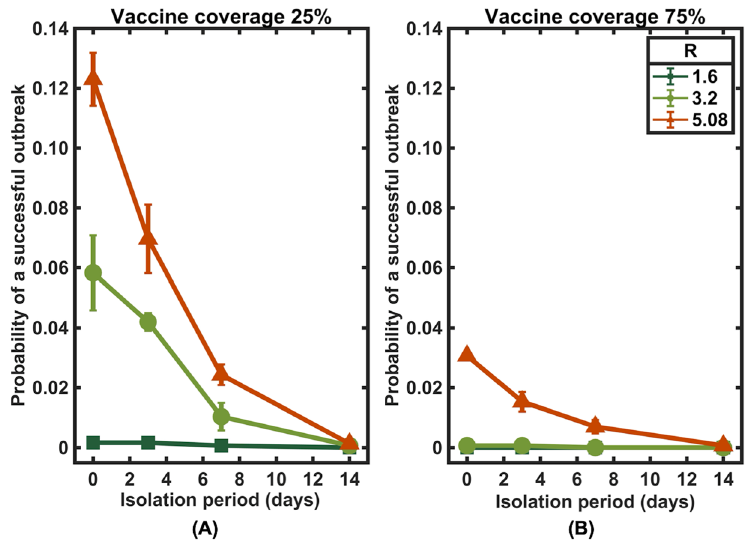
Figure 7. A sensitivity analysis of the effective reproduction number. The probability of a successful outbreak under community vaccination coverage levels of ( A ) 25% and ( B )